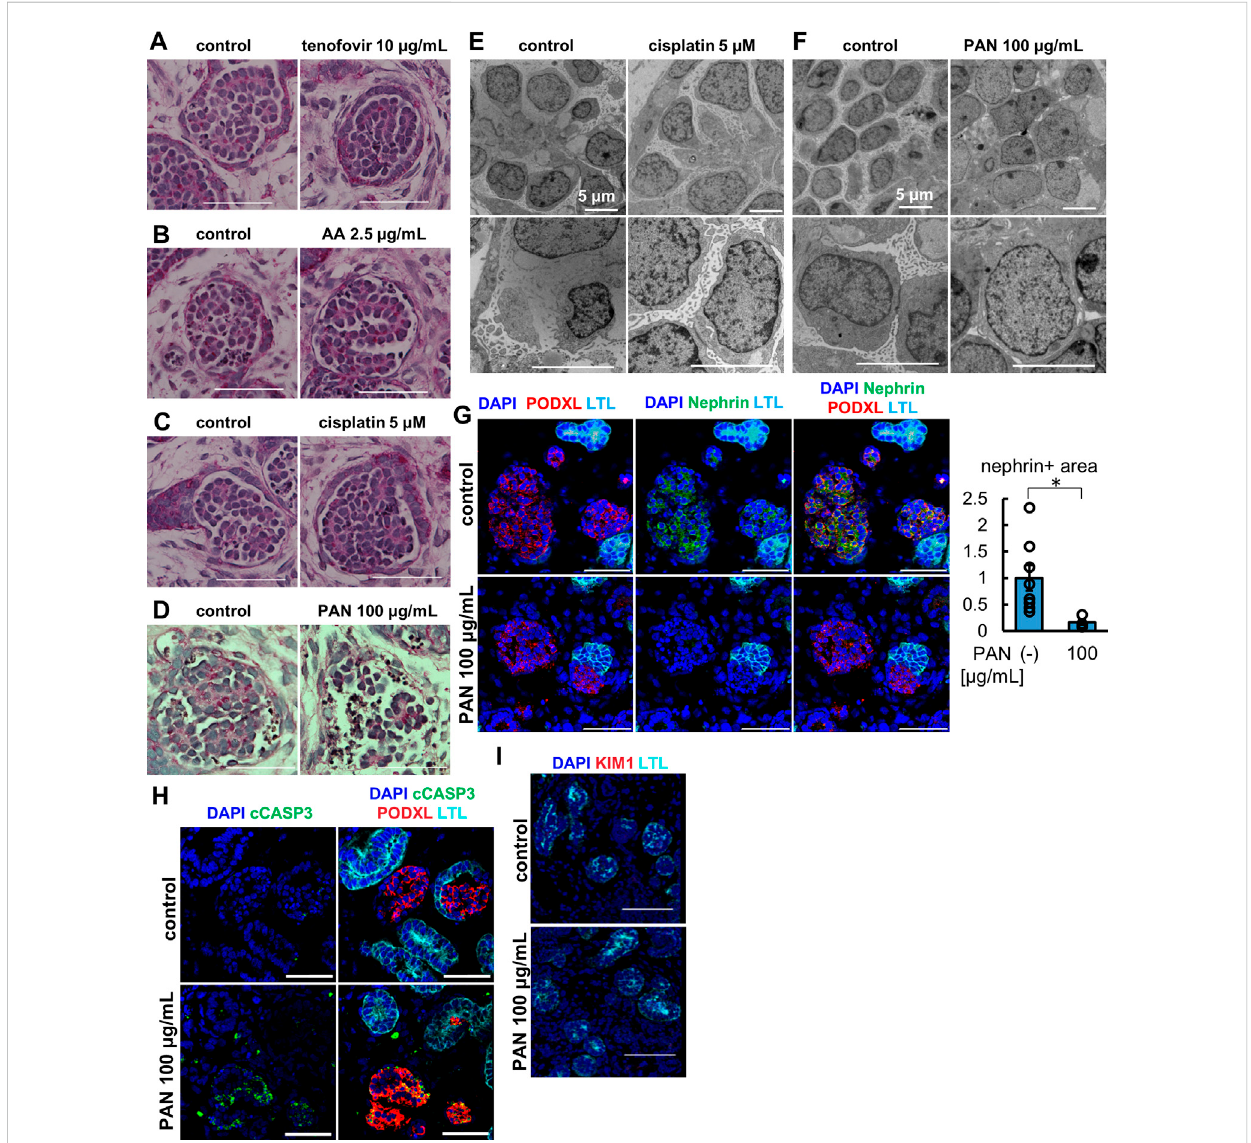
FIGURE 5 Glomerulus-speci fi c injury in kidney organoids under the treatment of PAN. (A – D) PAS staining of glomerular structure in (A) the organoids treated with 10 μ g/mL tenofovir for 7 days, (B) the organoids treated with 2.5 μ g/mL AA for 48 h, (C) the organoids treated with 5 μ M cisplatin for 24 h (D) the organoidstreatedwith100 μ g/mLPANfor24 h.Scalebar:50 μ m. (E,F) Electronmicroscopyimagesofglomerularstructuresin (E) theorganoidstreated with 5 μ M cisplatin for 24 h and (F) the organoids treated with 100 μ g/mL PAN for 24 h. Scale bar: 5 μ m. (G) IF of nephrin (green), podocalyxin (PODXL,red),andLTL(cyan)intheorganoidstreatedwith100 μ g/mLPANfor24 h.N=8glomerularstructuresfrom3independentorganoids. *p < 0.05. Scale bar: 50 μ m. (H) IF of cCASP3 (green), podocalyxin (PODXL, red), and LTL (cyan) in the organoids treated with 100 μ g/mL PAN for 24 h. Scale bar: 50 μ m. (I) IF of KIM1 (red) and LTL (cyan) in the organoids treated with 100 μ g/mL PAN for 24 h. Scale bar: 50 μ